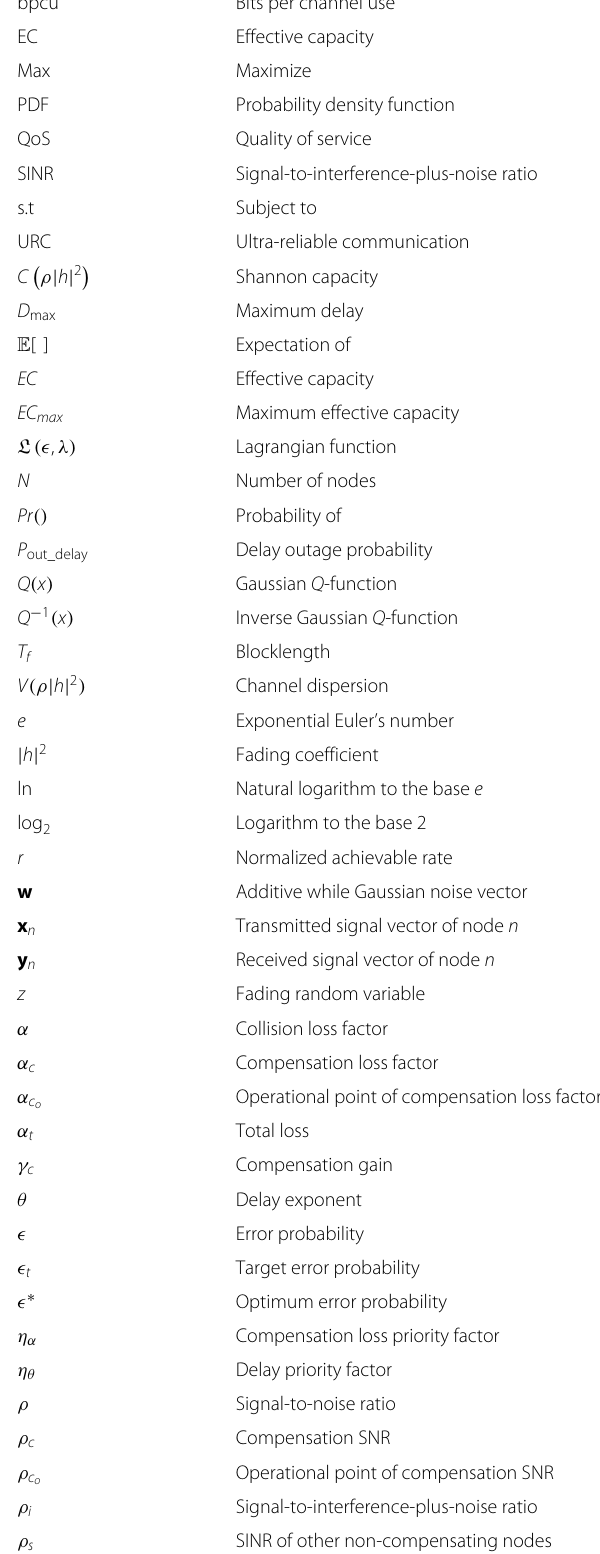
Table 1 List of abbreviations and